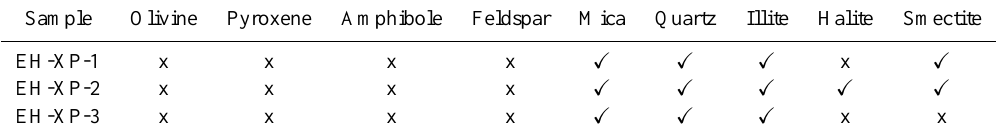
Table 1. Minerals present in “restingolite” samples from XRD analysis. For representative analytical spectra see Appendix Figs. A2 and A3. Sample